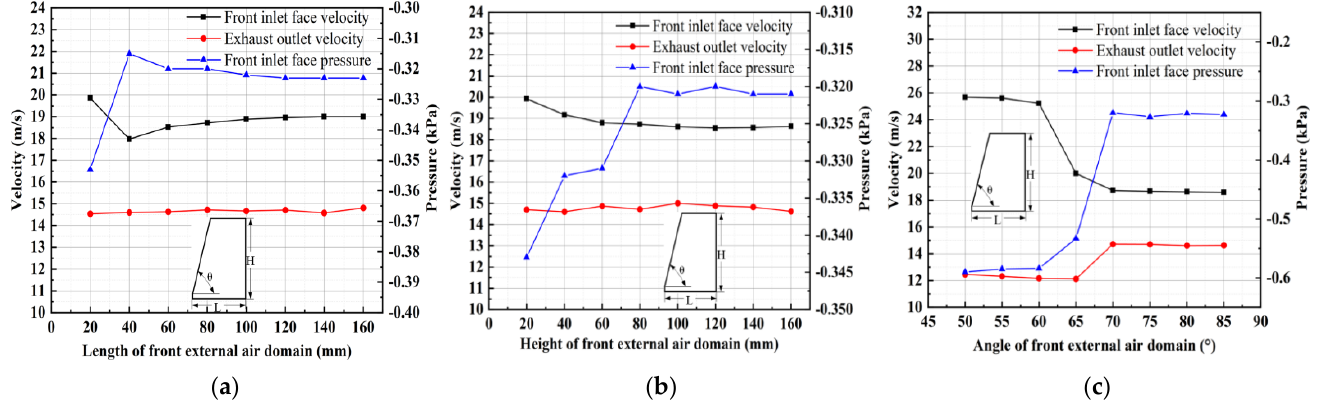
Figure 4. Influence of geometric parameters of the external expansion domain on the accuracy of the calculation: ( a ) the effect of length on accuracy of calculation; ( b ) the effect of height on the accuracy of the calculation; ( c ) the effect of angle on the accuracy of the calculation.